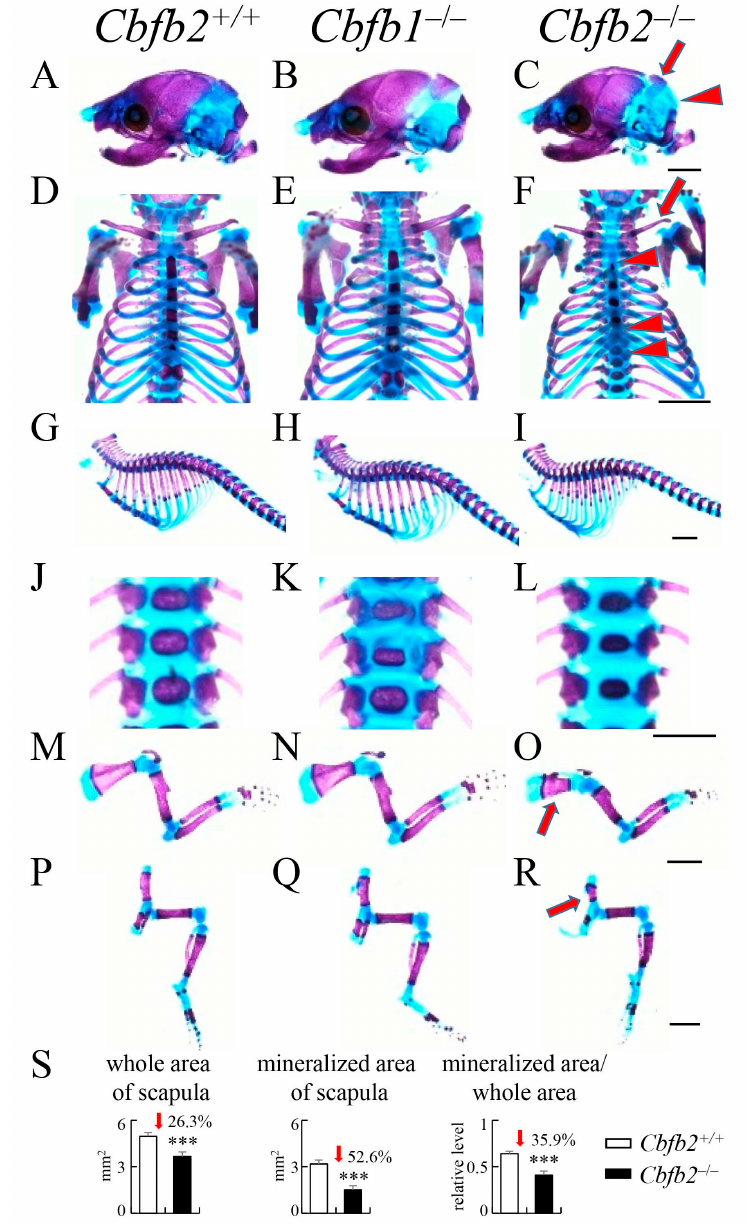
Figure 2. Skeletal development in Cbfb2 +/+ , Cbfb1 − / − and Cbfb2 − / − newborn mice. Cbfb1 +/+ mice were similar to Cbfb2 +/+ mice, and are not shown here. ( A – C ) Lateral view of skulls. ( D – F ) Neck and chest. ( G – I ) Lateral view of ribs and vertebrae. ( J – L ) Enlarged pictures of vertebrae. ( M – O ) Forelimbs. ( P – R ) Hind limbs. The arrow and arrowhead in ( C ) show delayed mineralization of interparietal bone and supraoccipital bone, respectively. The arrow and arrowheads in ( F ) show thin clavicle and delayed mineralization of sternum, respectively. The arrows in ( O ) and ( R ) show delayed mineralization of scapula and pelvic bones, respectively. Scale bars: 0.2 cm. ( S ) Whole area and mineralized area of scapulae and the ratios. The number of mice analyzed: Cbfb1 +/+ , n = 3; Cbfb1 –/– , n =2; Cbfb2 +/+ , n = 5; Cbfb2 –/– , n = 4. *** p < 0.001.